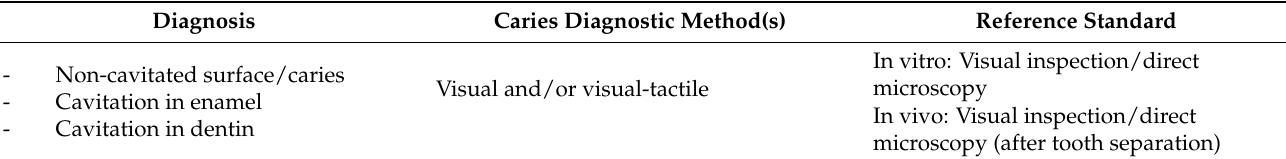
Table 3. Overview of possible caries diagnostic methods and reference standards in relation to dental